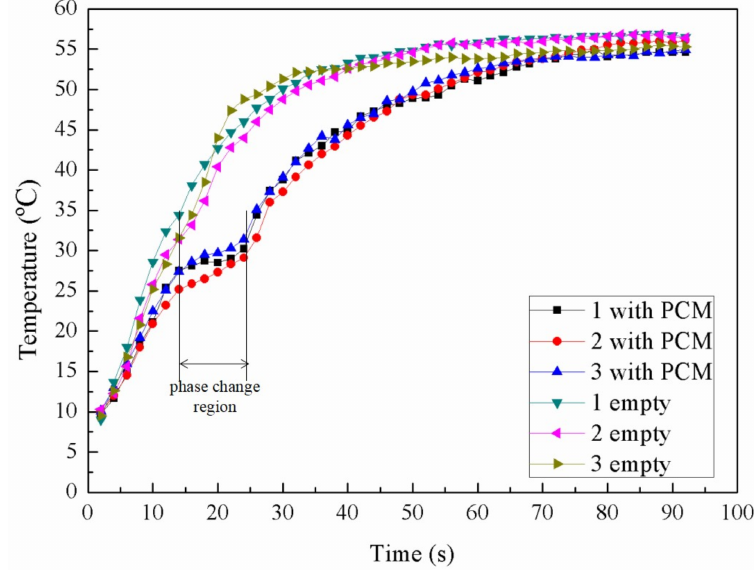
Figure 13. The temperature variation of the three empty chips and three chips with PCM over time.